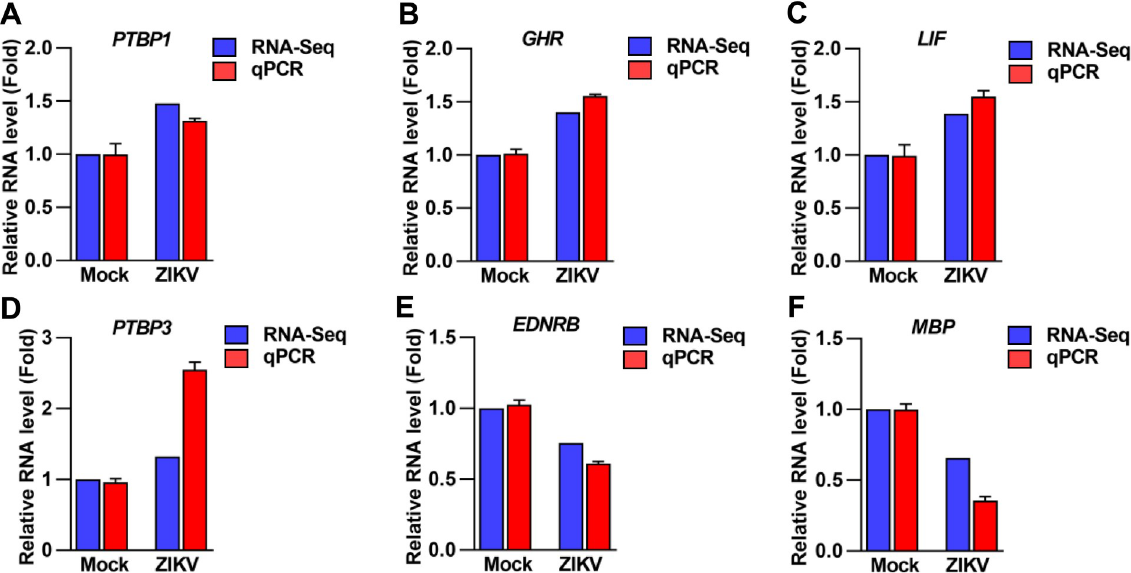
Fig 5. Validation of astrocytic altered genes upon ZIKV infection. MPAs were infected with ZIKV at MOI of 2 for 0 and 24 h, respectively. ( A - F )The expression patterns of top 6 shortlisted genes: PTBP1 (A), GHR (B), LIF (C), PTBP3 (D), EDNRB (E), and MBP (F), were measured by RNA-seq and qRT-PCR (qPCR), respectively. GAPDH was used as an internal control in qRT-PCR. The individual bars represent the qPCR data as the means ± SD, n = 3. The underlying numerical data for “Fig 5A–5F” is provided in the supporting file “S1 Data”.